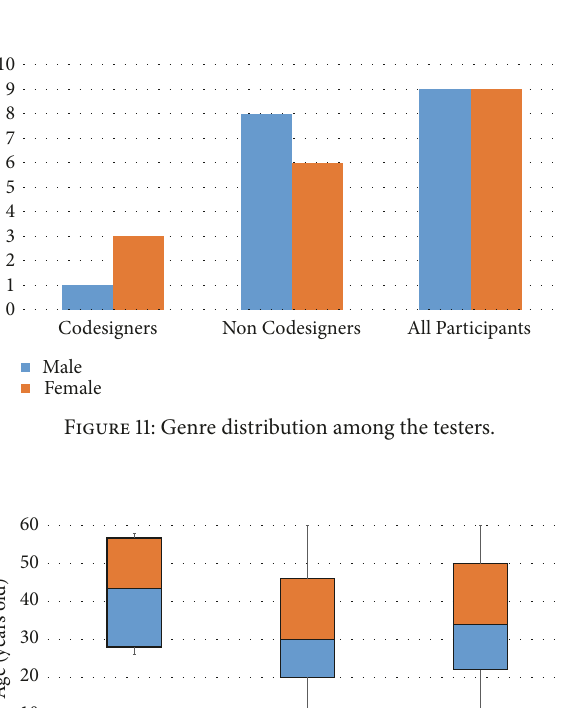
Figure 10: Revised flow of the game stages: with the new configuration, players can quit the game or return to the House stage at any time during gameplay.